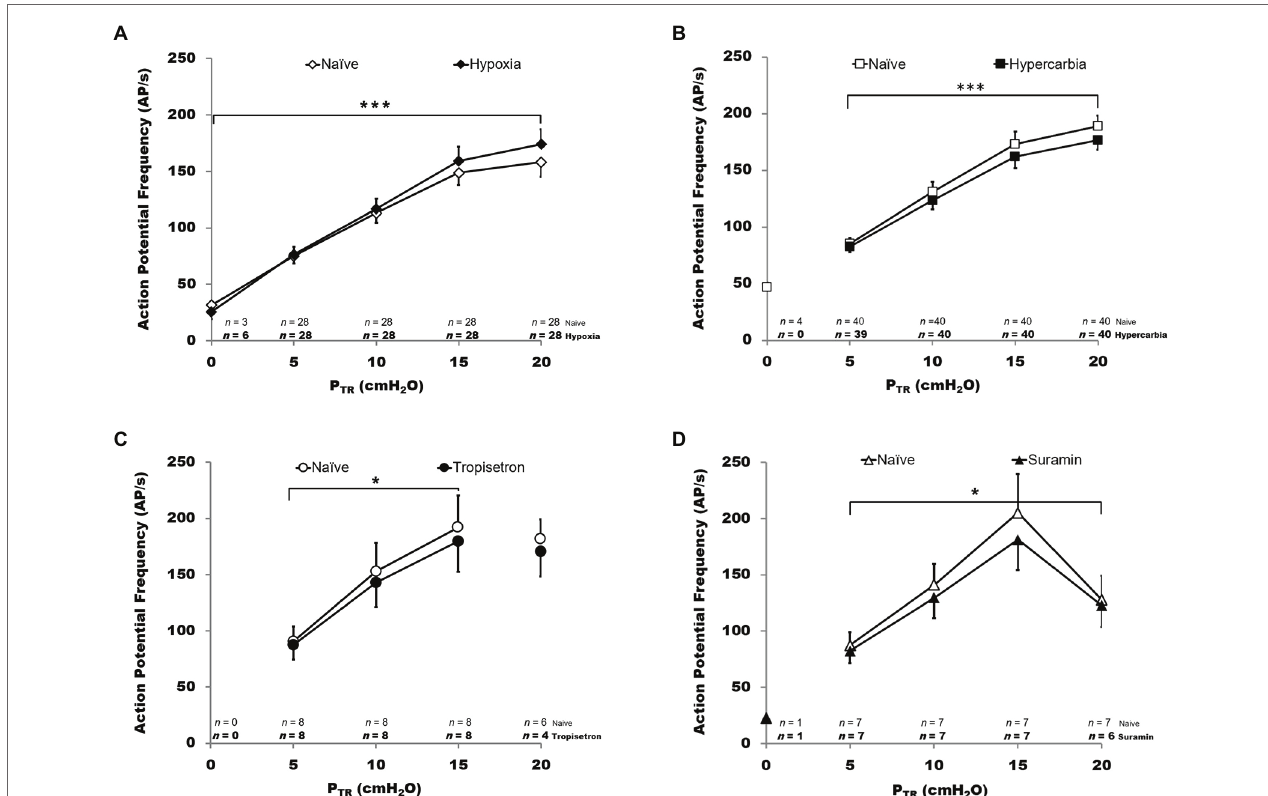
FIGURE 8 | Impact of chemosensory and pharmacologic challenge on SAR activity during slow inflation. Action potential frequency (AP f in AP/s) is plotted for P TR from 0 to 20 cmH 2 O. In all graphs, hollow symbols represent the naïve trials and filled symbols represent the experimental condition. The n values at the bottom of each panel indicate the number of SARs active ( n ) at each pressure, with experimental condition n indicated in bold below the naïve condition n values. Hypoxia ( panel A , top left ): hypoxia was associated with a small but statistically significant increase in AP f ( p < 0.001). Hypercarbia ( panel B , top right ): in contrast, hypercarbia was associated with a small but statistically significant decrease in AP f ( p < 0.001). Tropisetron ( panel C , bottom left ): pretreatment with Tropisetron was associated with a small but statistically significant decrease in AP f ( p < 0.01). Suramin ( panel D , bottom right ): pretreatment with Suramin was associated with a small but statistically significant decrease in AP f ( p < 0.01). All data are mean ±